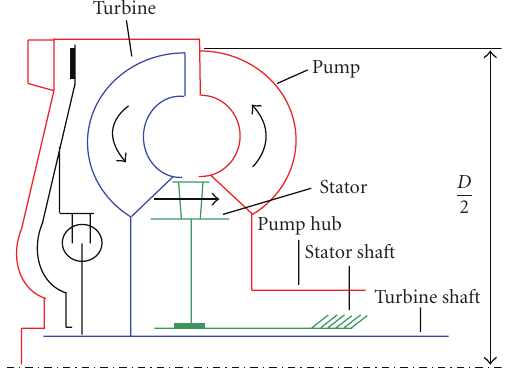
Figure 1: Cross-section schematic of a modern three-element torque converter; arrows indicate direction of toroidal